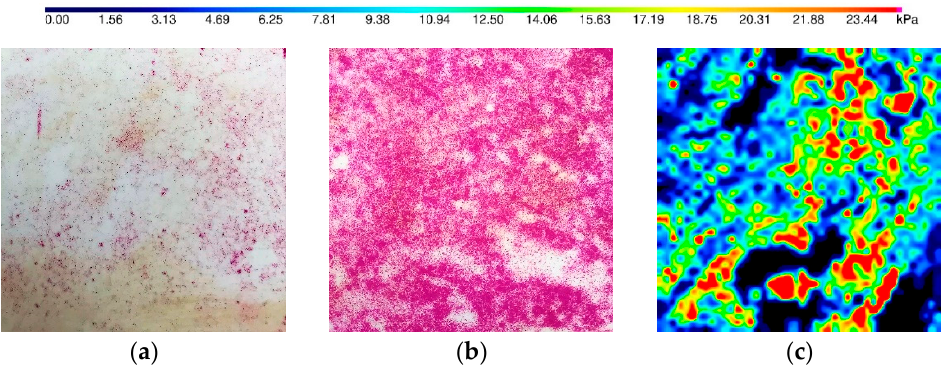
Figure 13. Pressure in the soil below the 10 cm thickness compacted layer measured by: ( a ) 4 LW color film sensor; ( b ) 5 LW color film sensor; ( c ) tactile sensor.